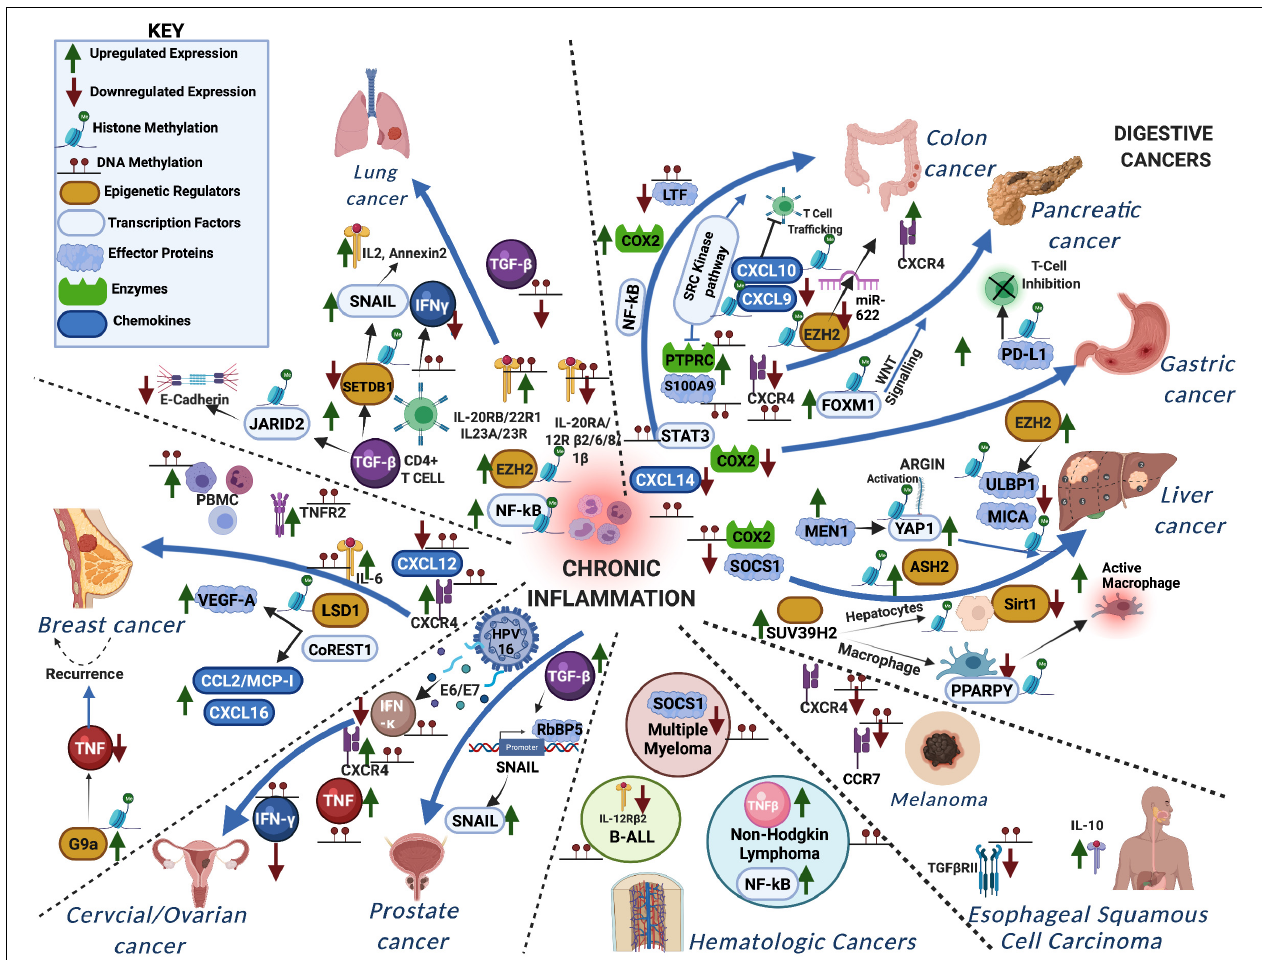
FIGURE 2 | A schematic representation showing how aberrant DNA and histone methylation affect the different inflammatory signaling pathways in various forms of cancer. The different proteins functioning in the chronic inflammatory network are either methylated or trigger methylation of other proteins leading to the different